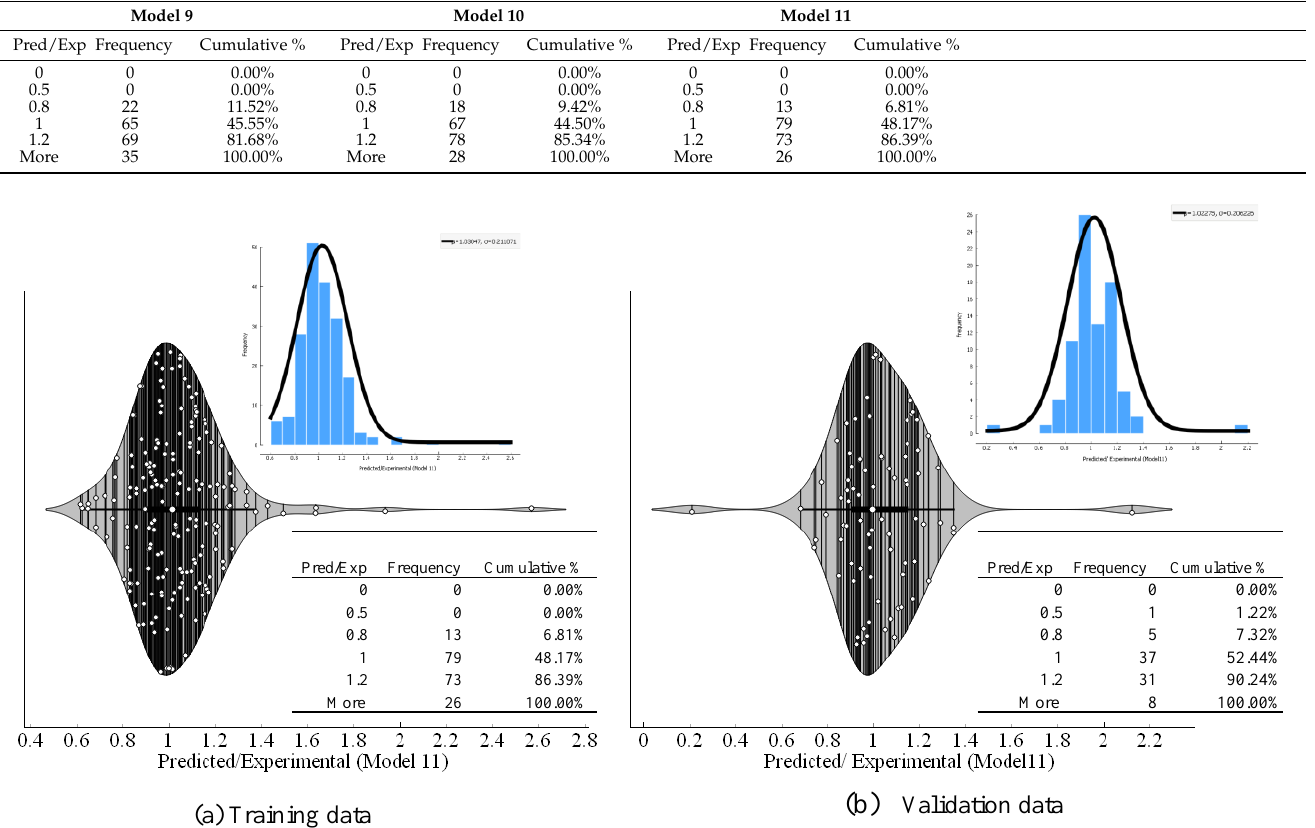
Figure 10. Predicted/experimental ratios of the optimum model: ( a ) Training data, and ( b ) Validation